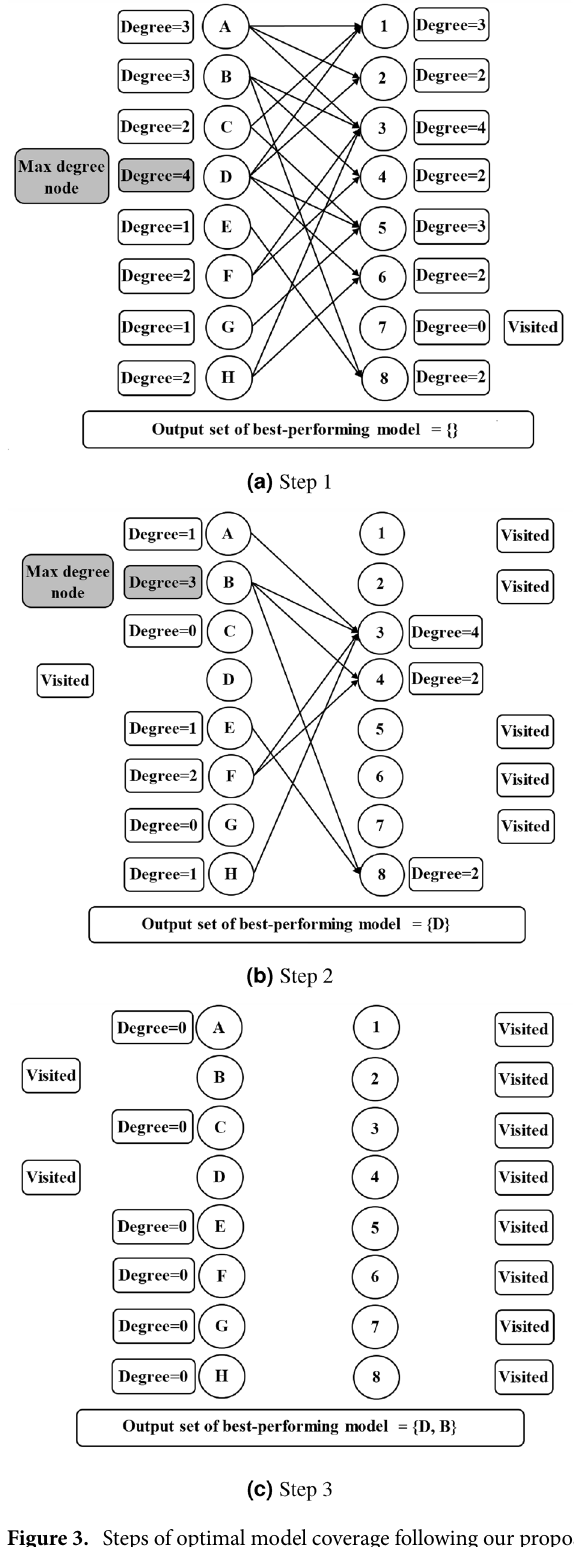
Figure 3. Steps of optimal model coverage following our proposed algorithm based on graph-based